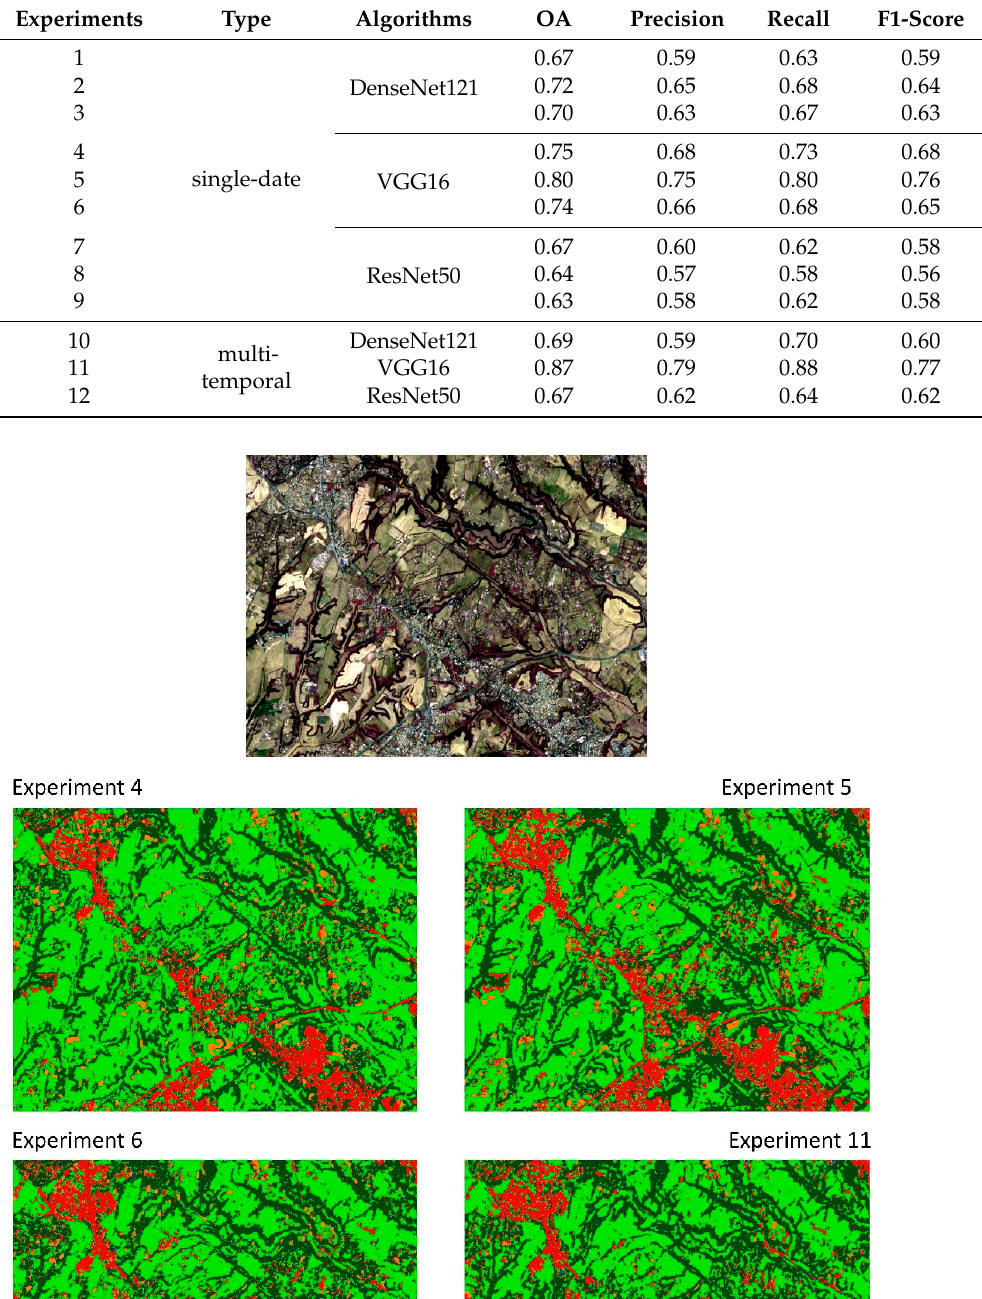
Table 4. Overall accuracy (OA), Precision, Recall and F1-Score of the validation phase for each of the 12 experiments.